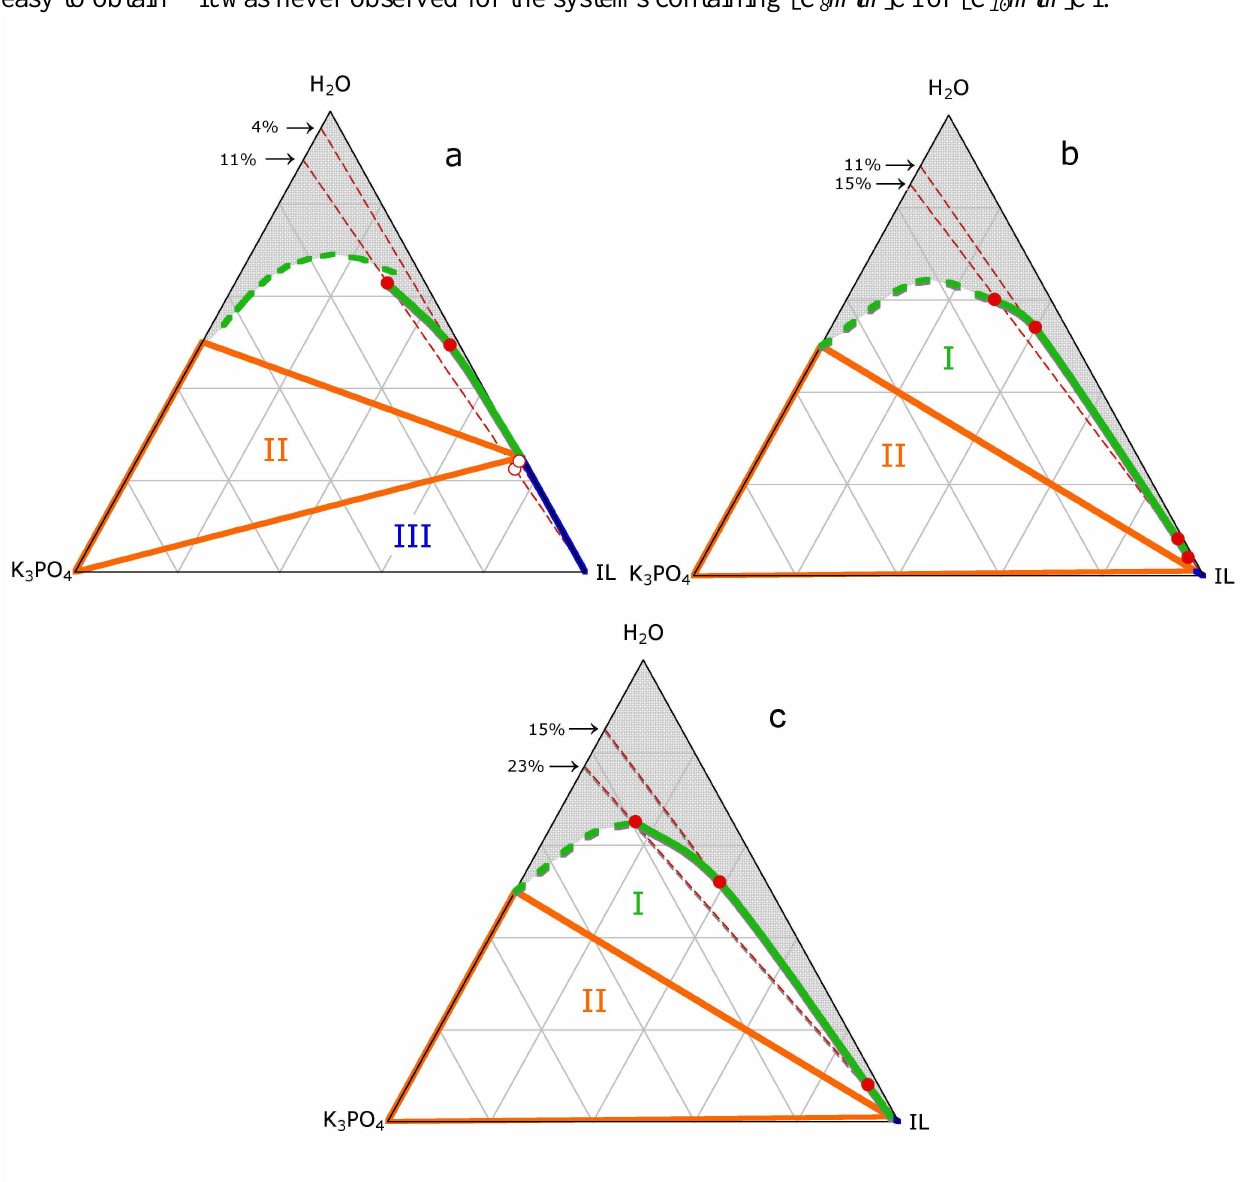
Figure 5. Ternary diagrams of (a) (K and (c) (K